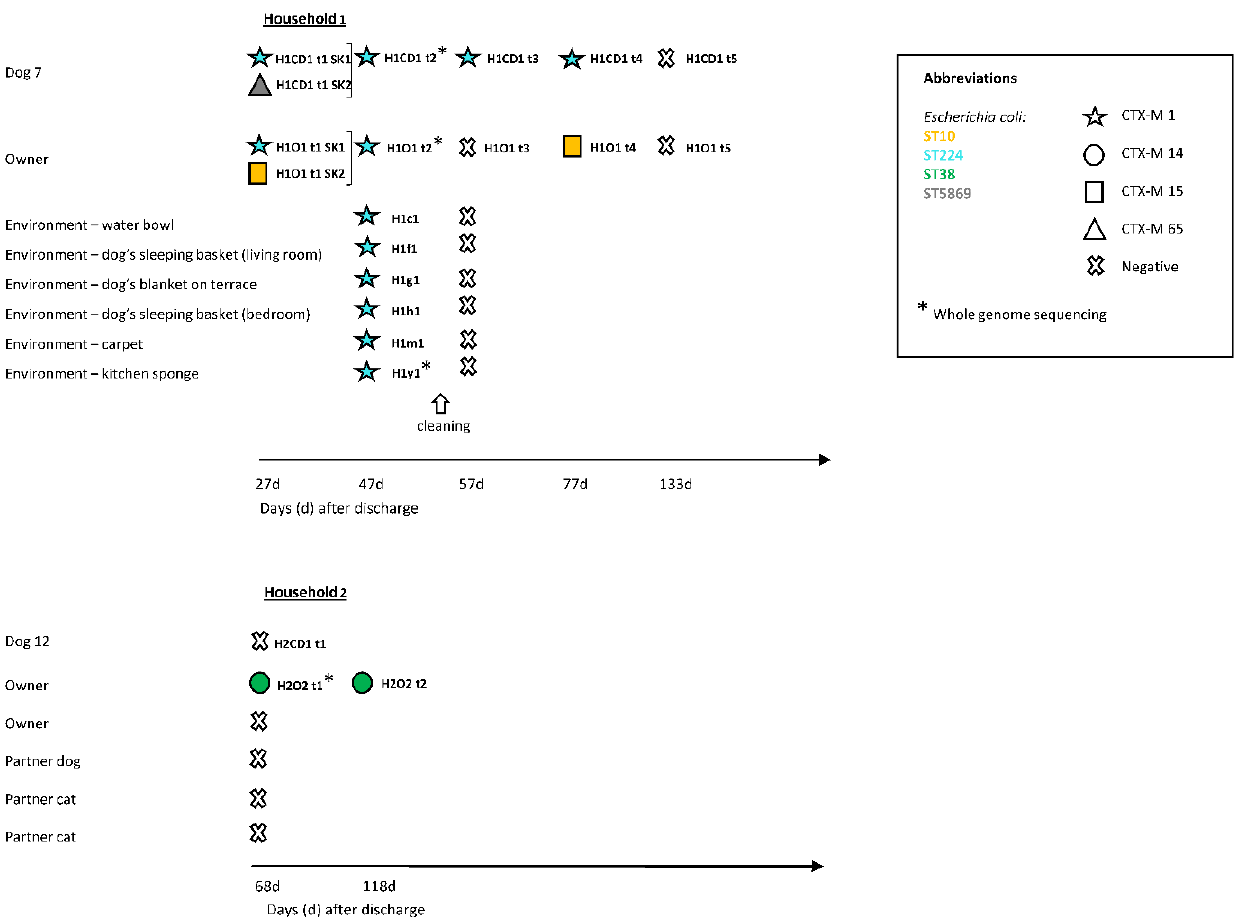
Figure 4. Timeline of extended spectrum beta-lactamase producing Enterobacteriaceae (ESBL-E) isolated from the dogs, cats and owners in household 1 and 2 and the household environment. CD, colonized dog; O, owner; d, days after discharge; H1, household 1; H2, household 2; H1c1, water bowl; H1f1, dog’s sleeping basket (living room); H1g1, dog’s blanket on terrace; H1h1, dog’s sleeping basket (bedroom); H1m1, carpet; H1y1, kitchen sponge; SK, subculture. Each horizontal line refers to a specimen obtained from the same animal, owner or environmental surface over time (12, t2, t3, t4, t5). The brackets at the right side of the strain ID indicate subcultures of the same specimen. Negative test results are only shown for animals, environmental surfaces or owners that had tested positive for ESBL-E at a certain time point.